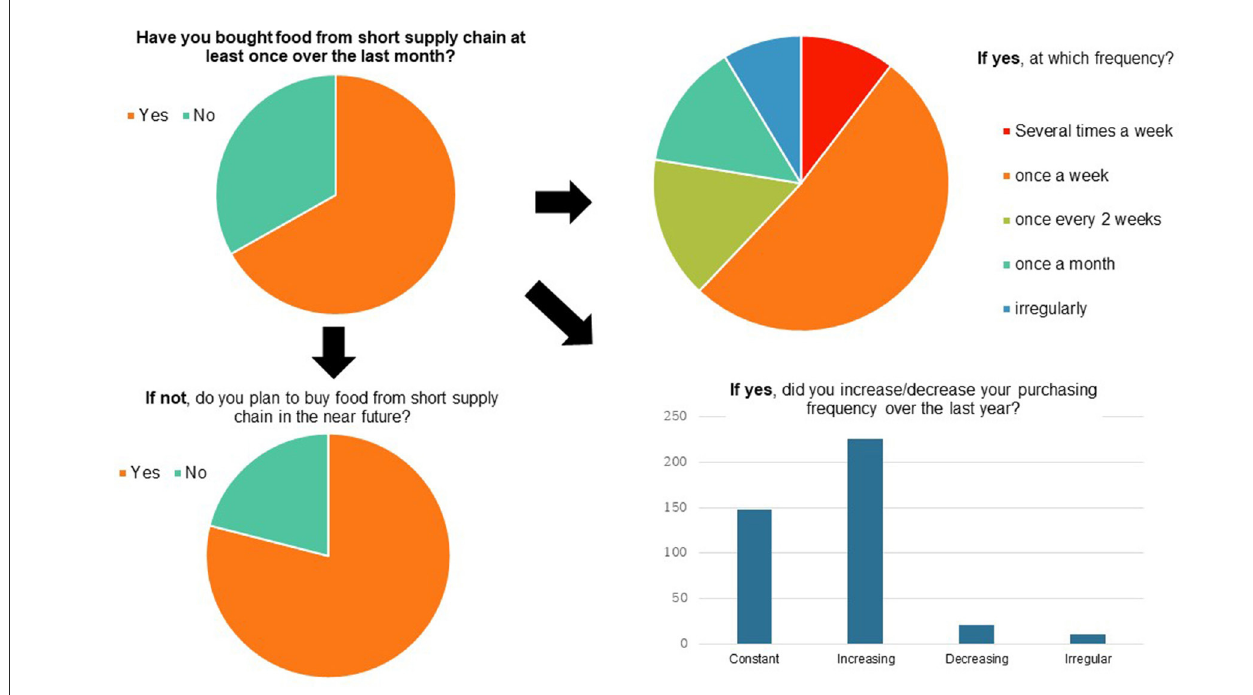
FIGURE5 Preliminary results of consumer surveys ( n =